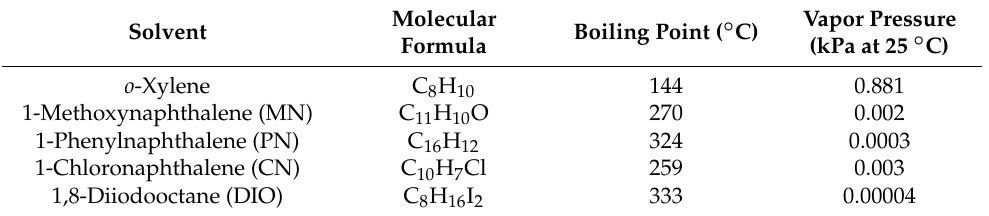
Table 1. Various physical properties of solvents and solvent additives used in this work [27].